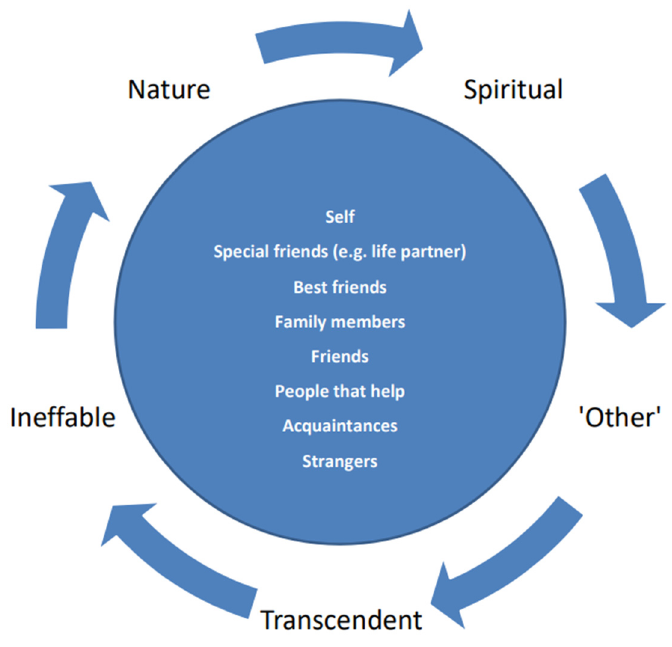
Figure 1. Mason and Woolley’s (2019) Taxonomy of Relationships,